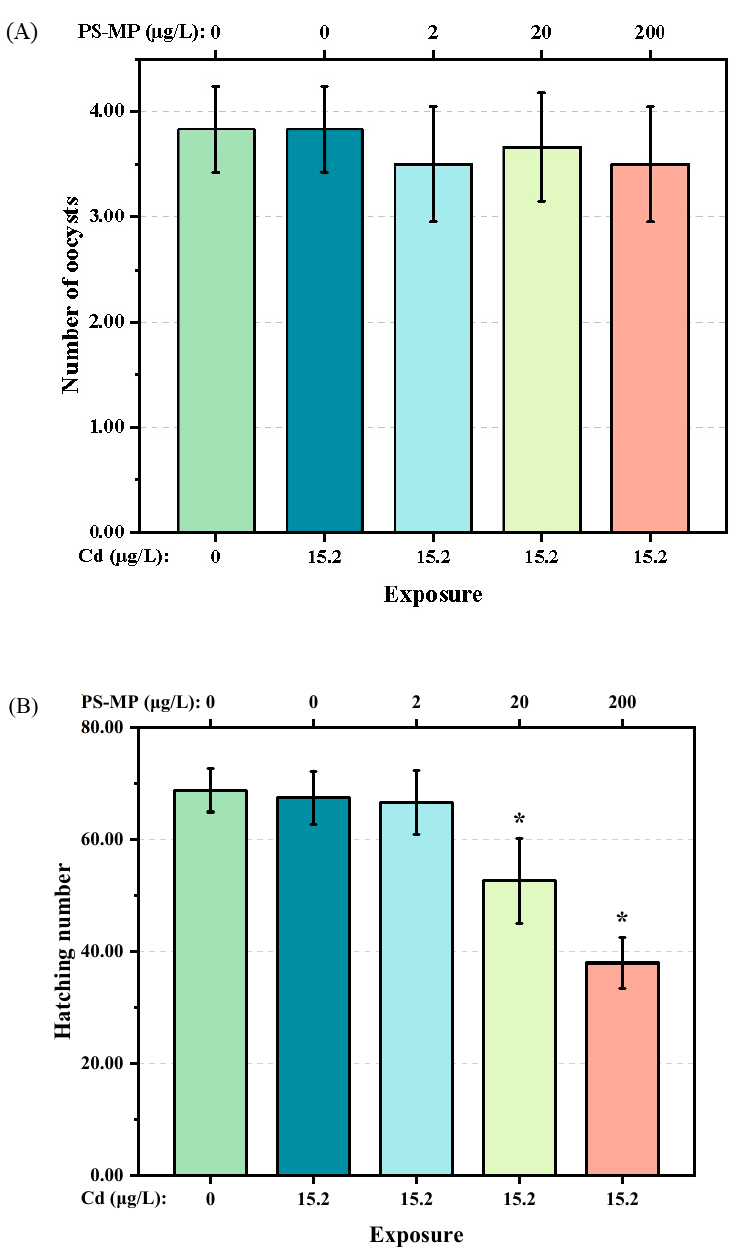
Figure 3. ( A ): Number of oocysts of the F1 generation and ( B ) hatching number of the F2 generation of T. japonicas exposure to Cd and PS-microplastic. The asterisks (*) indicate statistical differences compared with control group( p < 0.05)